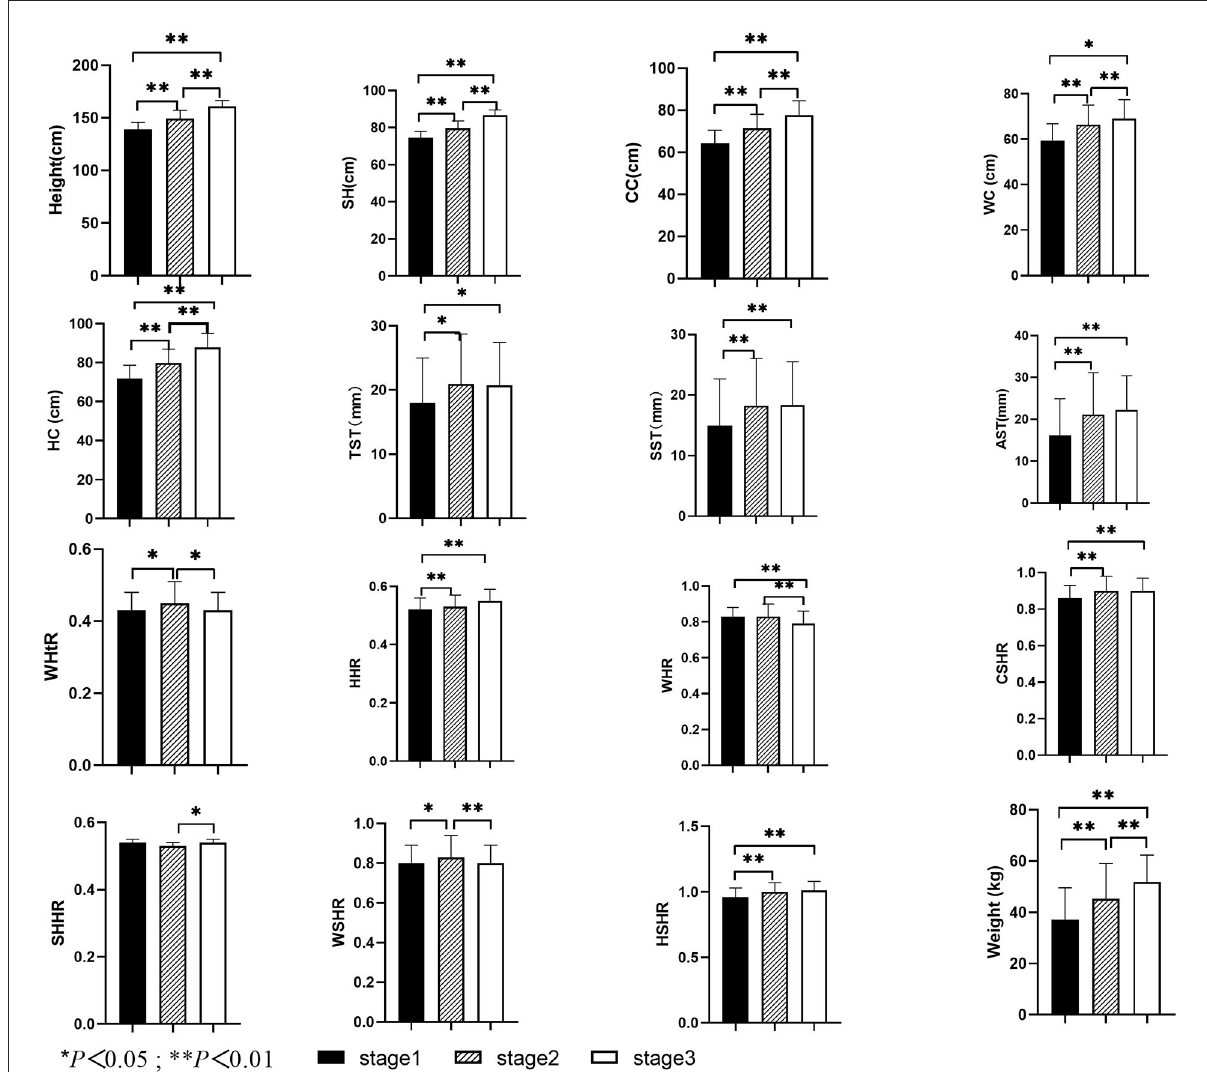
FIGURE2 Comparisons of height, SH, weight, CC, WC, HC, TST, AST, SST, HSHR, WHtR, HHR, WHR, CSHR, WSHR, SHHR among girls with different pubertal development